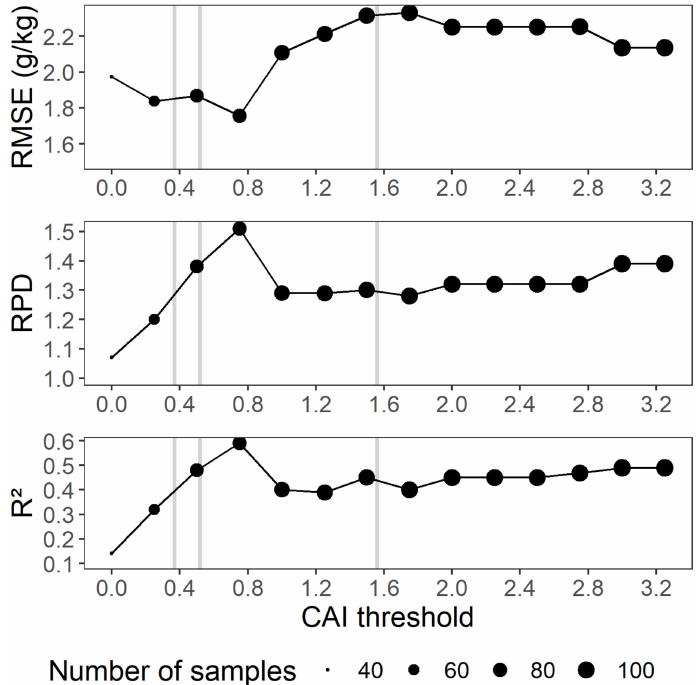
Figure 12. Coe ffi cient of determination (R 2 ), Ratio of Performance to Deviation (RPD) and Root Mean Square Error (RMSE) of the Partial Least Squares Regression (PLSR) models for SOC content as a function of Cellulose Absorption Index (CAI) thresholds. The vertical lines indicate the average CAI